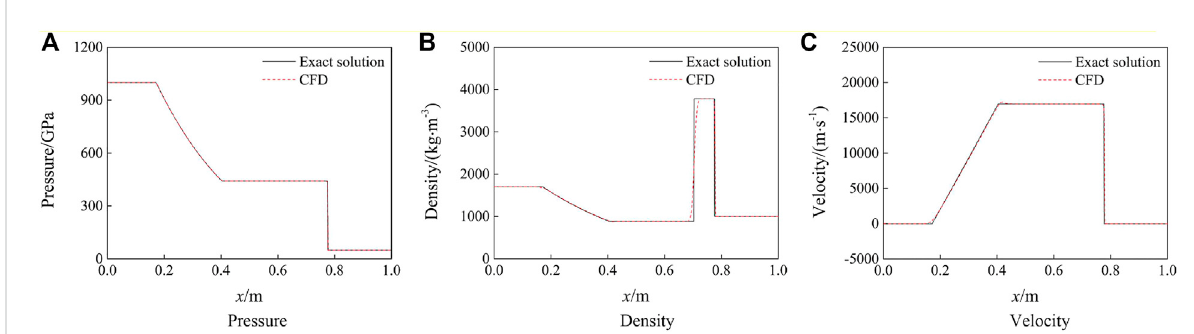
Comparison of numerical solutions and exact solutions. (A) Pressure. (B) Density. (C)